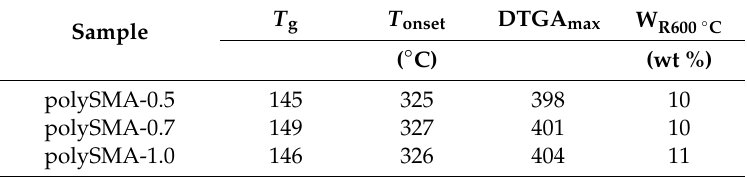
Table 3. Thermal properties of polySMA